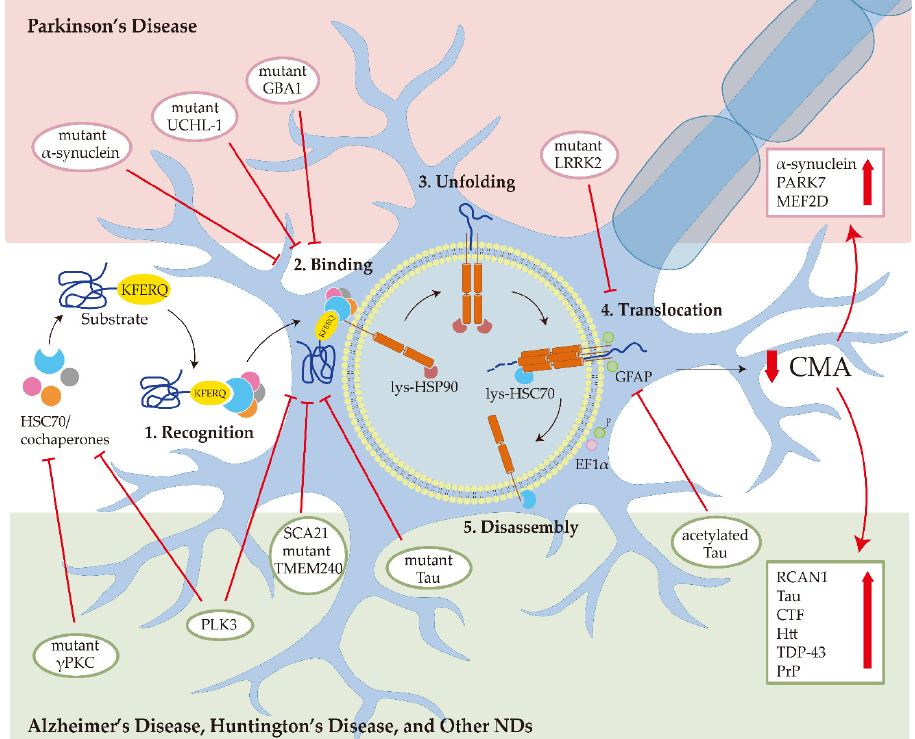
Figure 1. Chaperone-mediated autophagy (CMA) in neurodegenerative diseases (NDs). In Parkin- son’s disease, the mutant α -synuclein interacts with LAMP2A with higher affinity and blocks CMA degradation of other substrates; the mutant UCHL-1 and GBA1 reduce CMA activity by